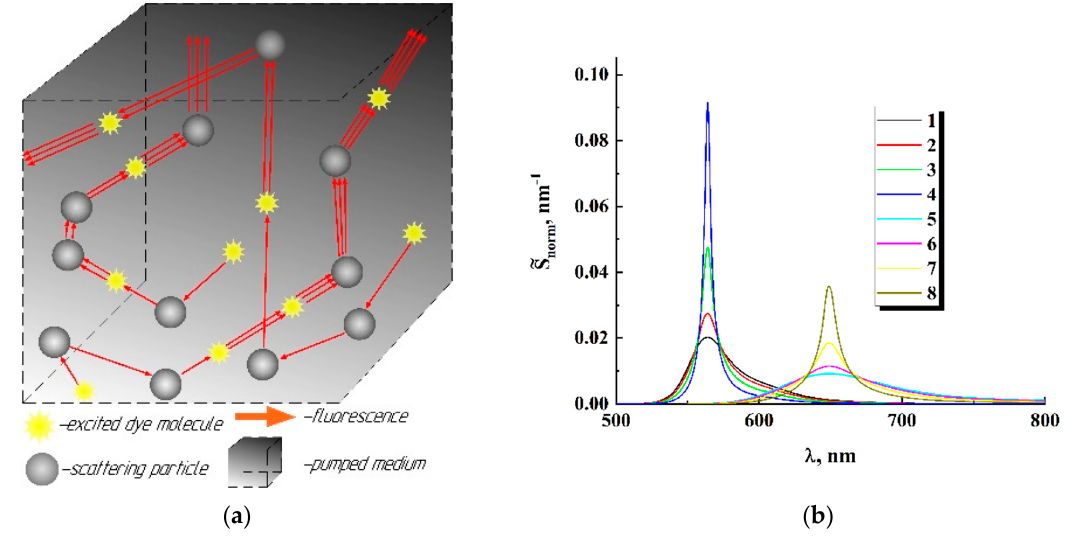
Figure 9. ( a ) Illustration of the considered probabilistic model; ( b ) modeled normalized spectra of fluorescence output of R6G-doped (1–4) and DCM-doped (5–8) pumped randomly inhomogeneous layers with l ∗ = 4 µ m; (1, 5) − l st = 1000 µ m; (2, 6) − l st = 250 µ m; (3, 7) − l st = 62.5 µ m; (4, 8) − l st = 15.63 µ